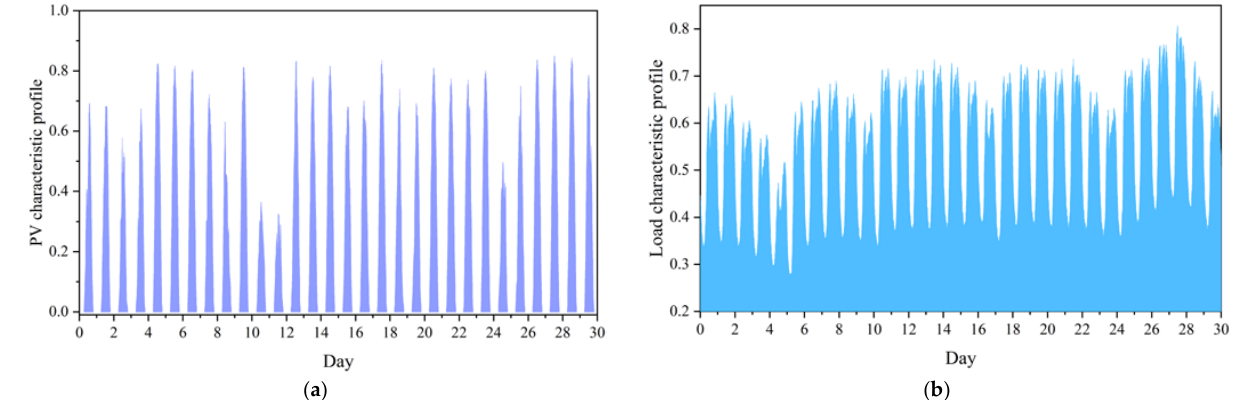
Figure 6. The characteristic profiles of PV ( a ) and load ( b ) in 30 days. The parameters of various equipment in the optimization model and the parameters of the improved PSO algorithm are shown in Table 1; the time-of-use price of electricity from the grid is shown in Table 2. Table 1. Basic parameter settings in the proposed solution.